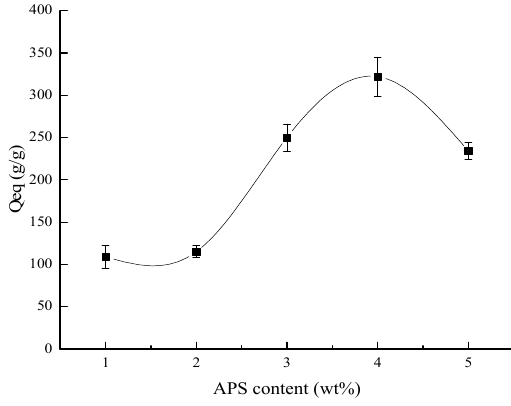
Figure 3. The influence of the ratio of initiator content to the monomer content on the water absorbency.